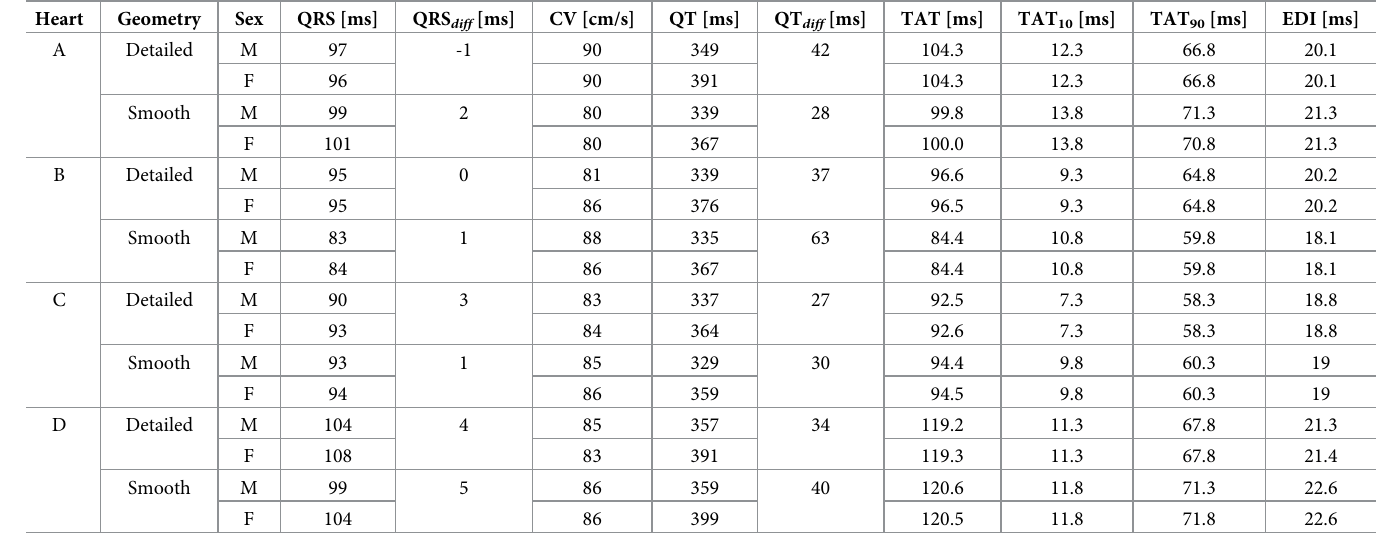
Table 2. Electrophysiological simulation results.